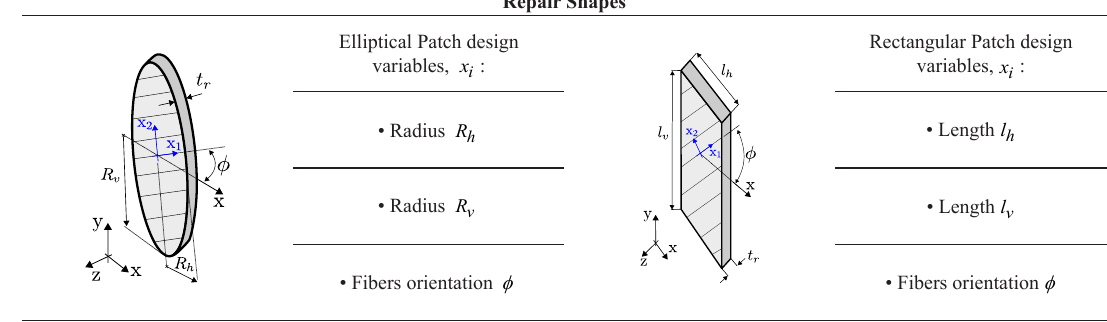
Rectangular Patch design variables, i x